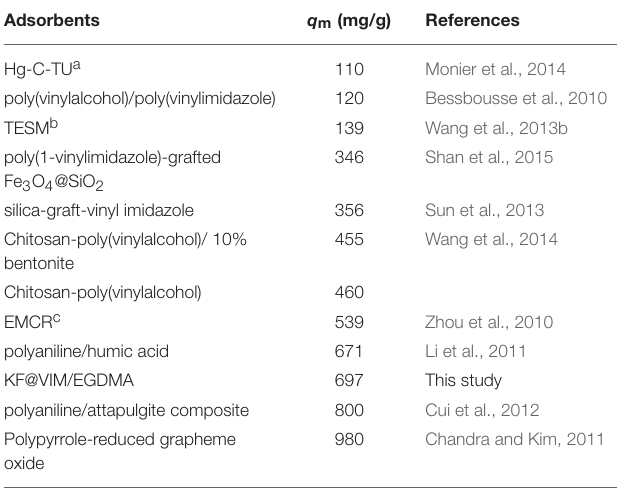
TABLE 2 | Maximum adsorption capacity ( q m ) of various adsorbents for Hg(II).